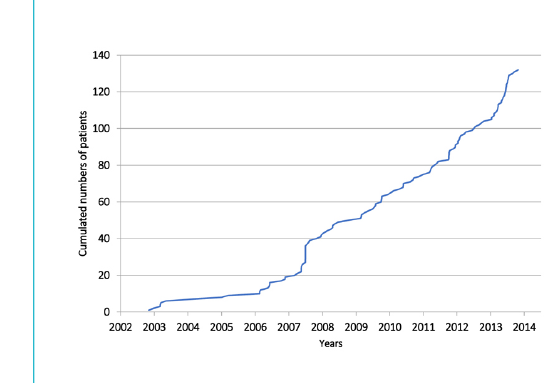
Figure 1: Cumulative number of patients during the length of the study.